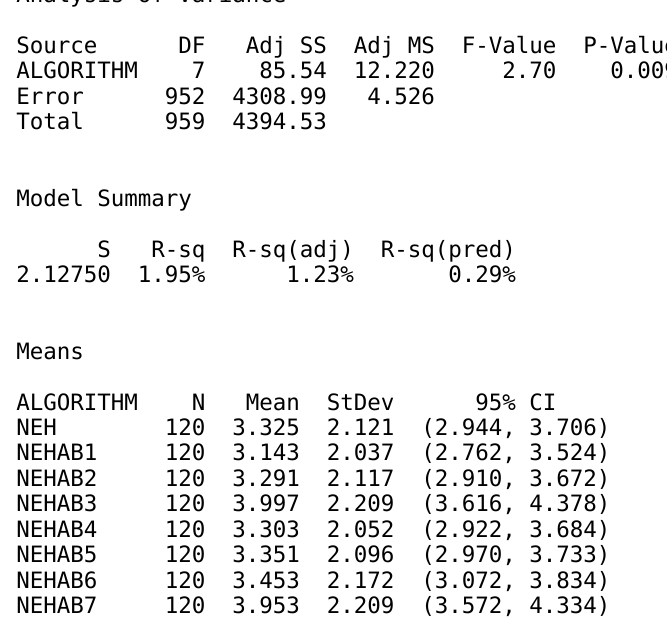
Fig.4. Box Plot for the Relative Deviations